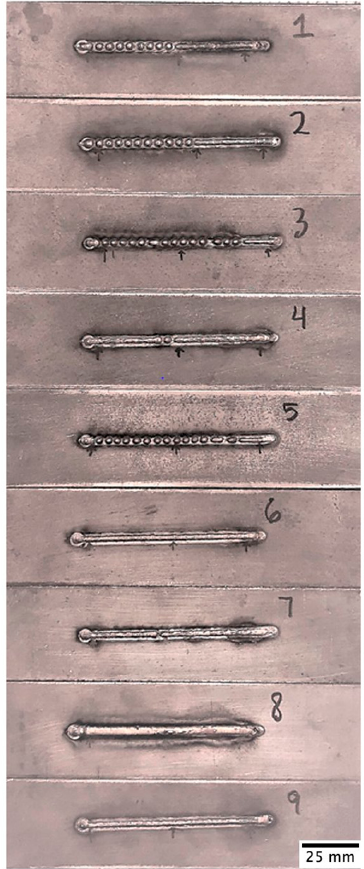
Figure 4. Deposited steel single-passes using the design of experiments parameters. The experiment numbers listed in Table 2 can also be seen in this figure.